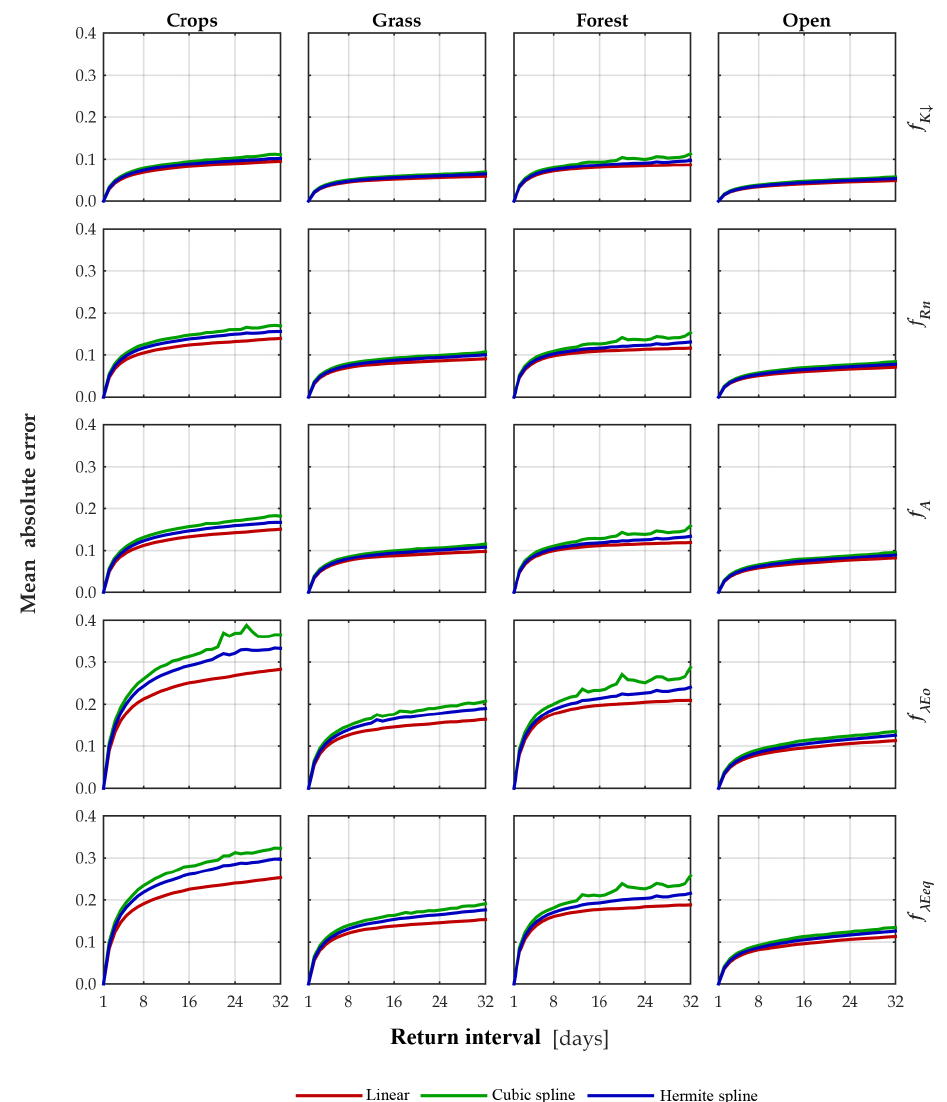
Figure 6. The mean absolute error (MAE) of the estimates of the scaled quantities is shown for each land cover type and interpolation